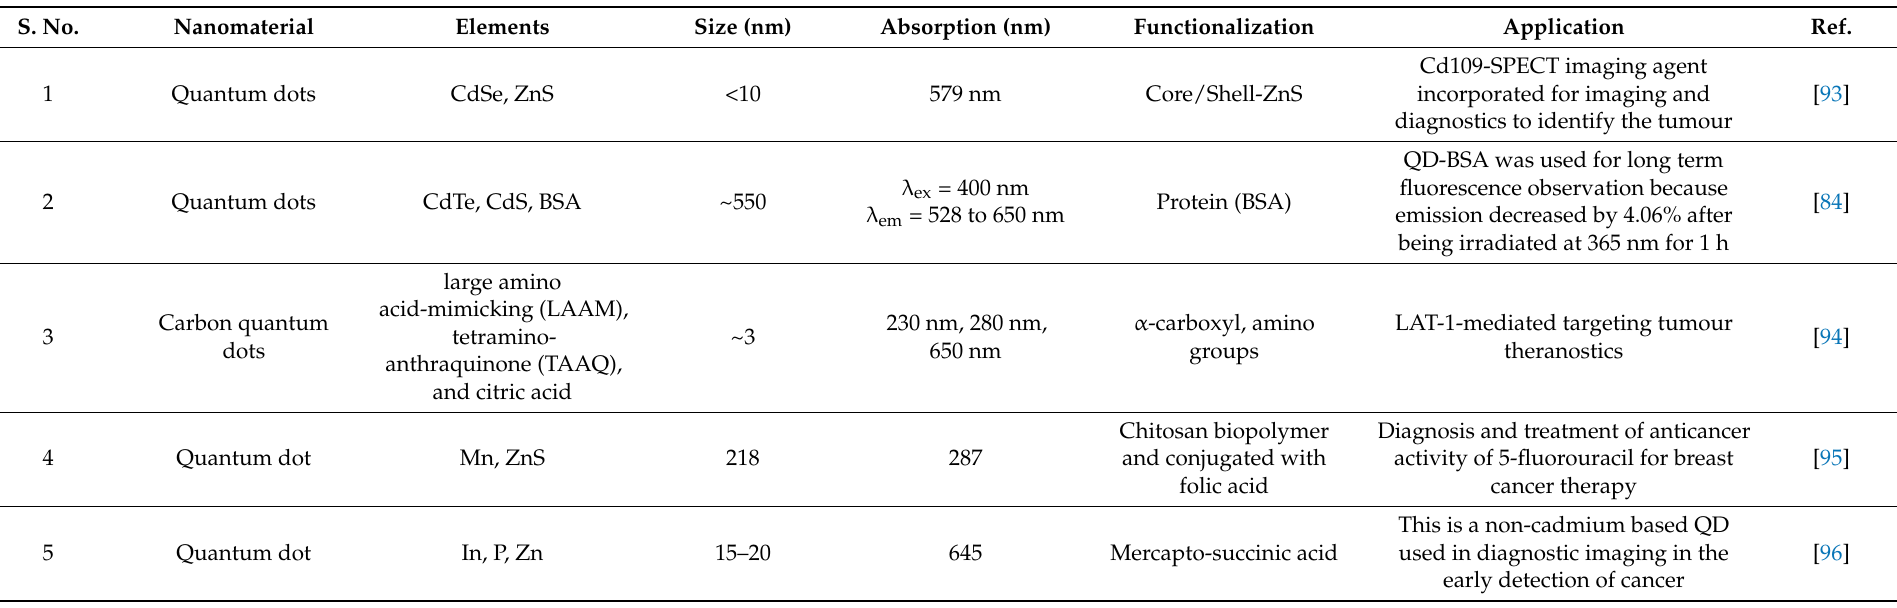
Table 1. Summarizes the list of zero-dimensional (0D) nanomaterials (e.g., quantum dots), their specification, and